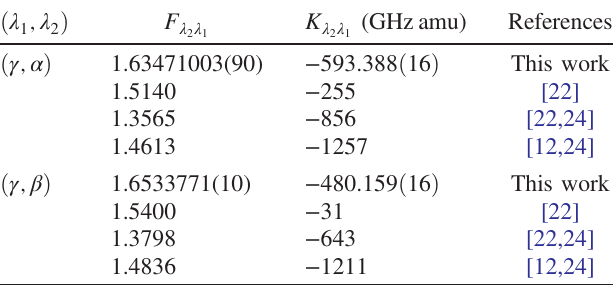
TABLE III. Best-fit parameters of 2D King plots shown in Figs. 6(a) and 6(b). Here, λ 1 represents the optical transition of γ , and λ 2 , α or β . The d.o.f. of χ 2 is 3 ¼ 5 (observations for α or β ) þ 4 (observations for γ ) − 2 (fitting parameters) − 4 (ISs on γ ). The error of each fit parameter is evaluated as 1 σ . The results are compared with the theoretical results in Refs. [12,22,24]. The values associated with Refs. [22,24] (Refs. [12,24]) are obtained by combining the MS and the FS of the γ transition in Ref. [24] and those of the α and β transitions in Ref. [22] (Ref. [12]).